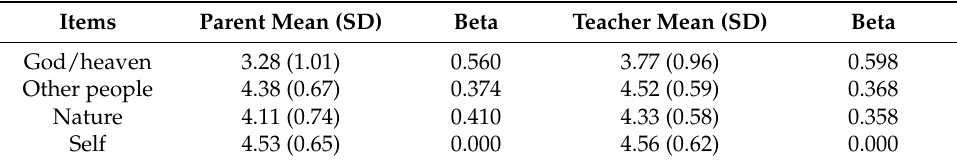
Table 10. Item values related to Regression Analyses of four items in